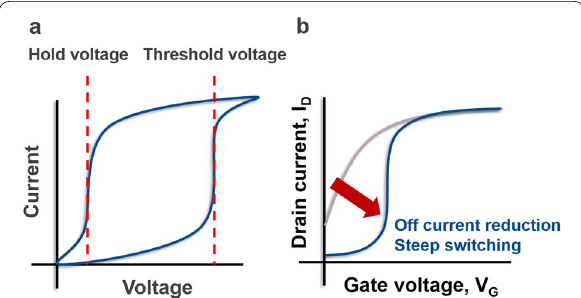
Fig. 4 Current–voltage characteristics of TS device and phase FET. a Current–voltage (I–V) characteristic of TS device. The TS device is turned on at threshold voltage, and tuned off at hold voltage. b Drain current vs. gate voltage (I D –V G ) characteristic of phase FET. Both the suppression of off-state leakage current and steep switching charac- teristic can be achieved, simply by connecting the TS device in series